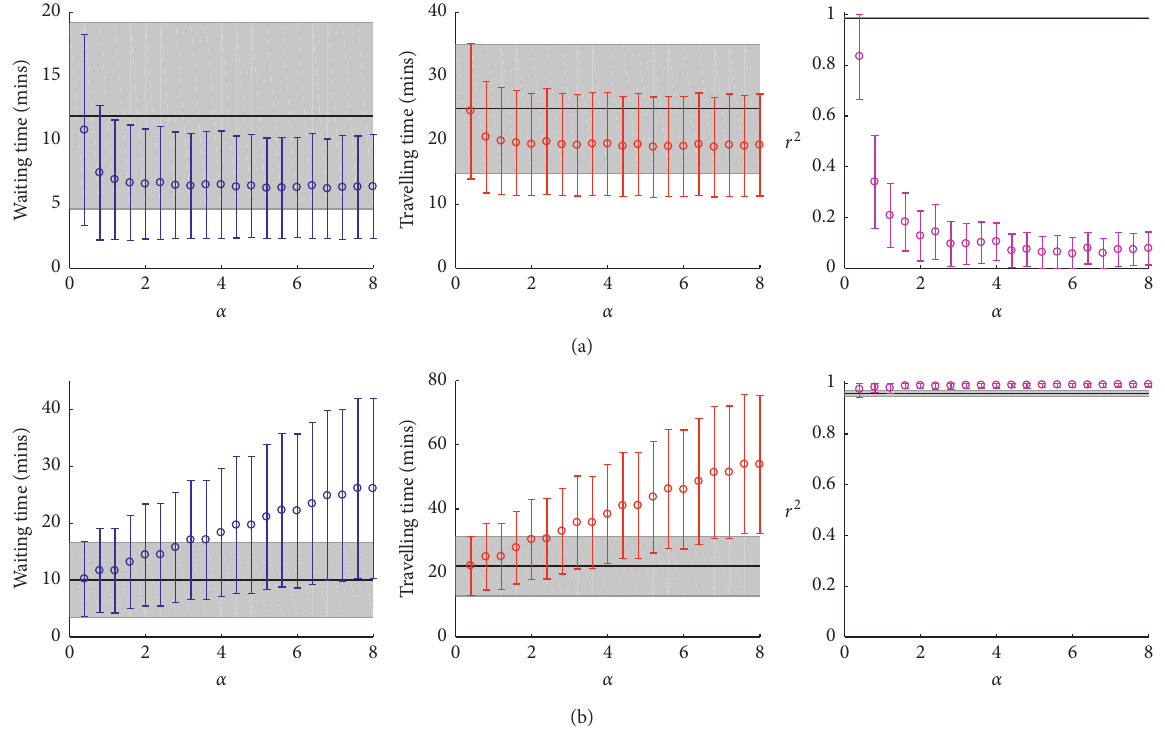
Figure 5: Results of the s-holding strategy in the two same-velocity scenarios. Each colored point represents the mean and standard deviation of the measured quantities calculated from 100 realizations of each parameter value. The black line and grey shaded area of each graph denote the mean and standard deviation of the measured quantities from a control case, which are simulation runs of the same parameter values, without any intervention strategies. (a) S-holding strategy in lull-same. (b) S-holding strategy in